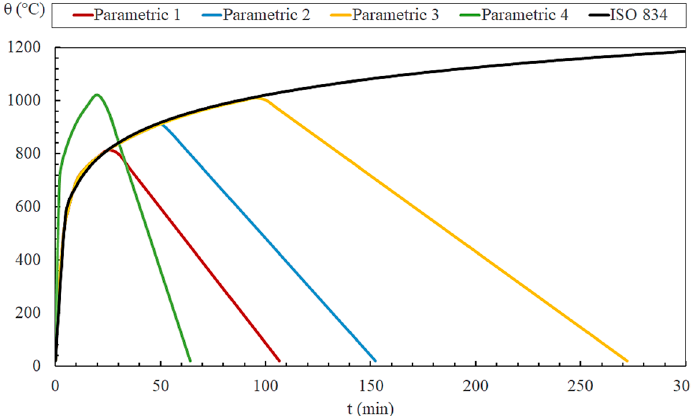
Figure 5. Parametric fire curves. Table 4. Data referring to parametric fire